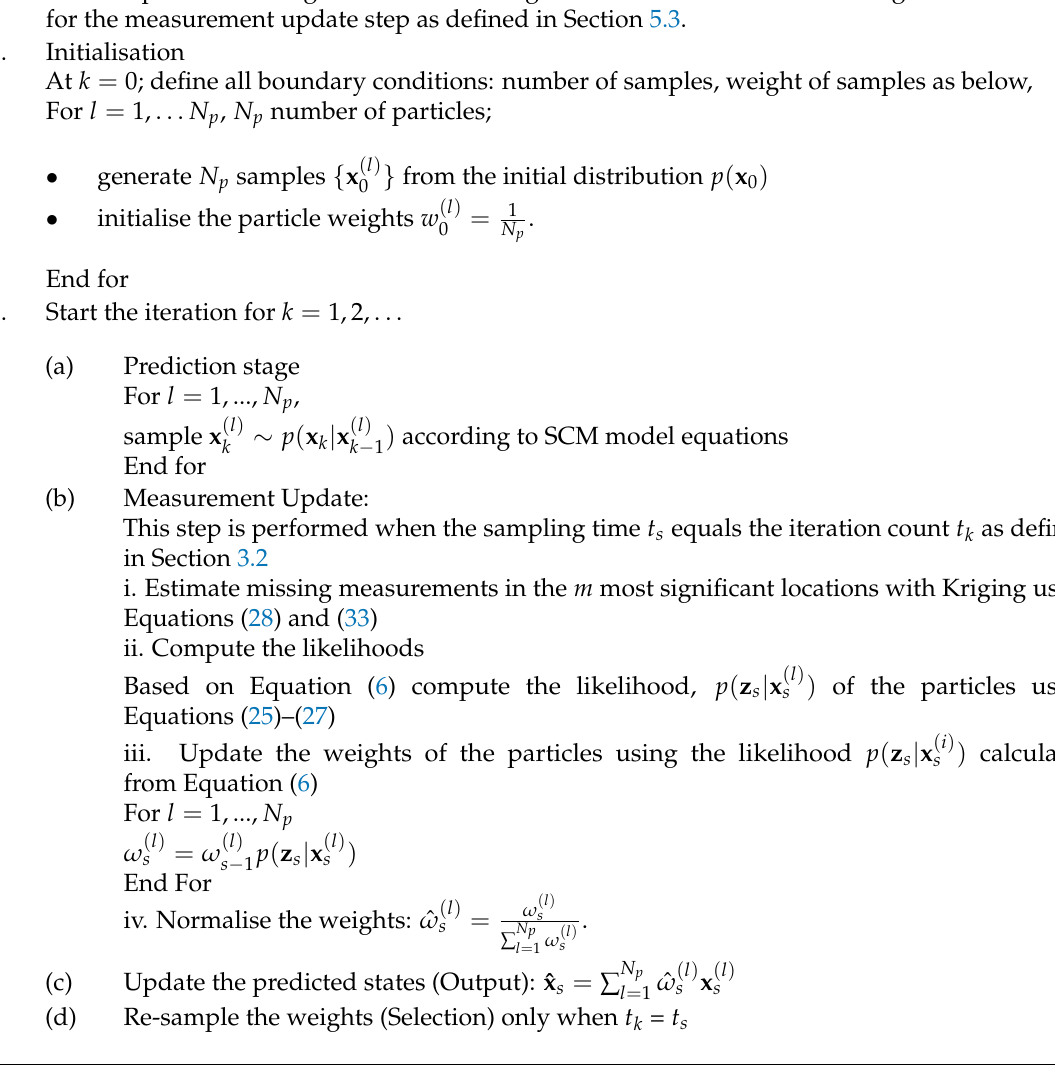
Algorithm 1 Particle Filter for Traffic State Estimation with Kriging Estimated Measurements [24]